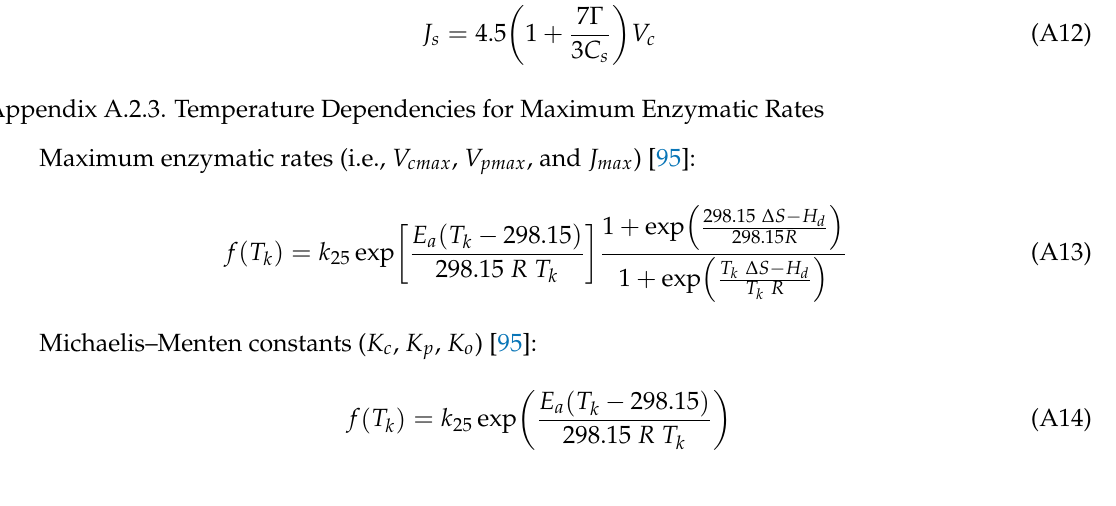
Table A1. C 4 Photosynthesis Model Variables in DCHM-V.